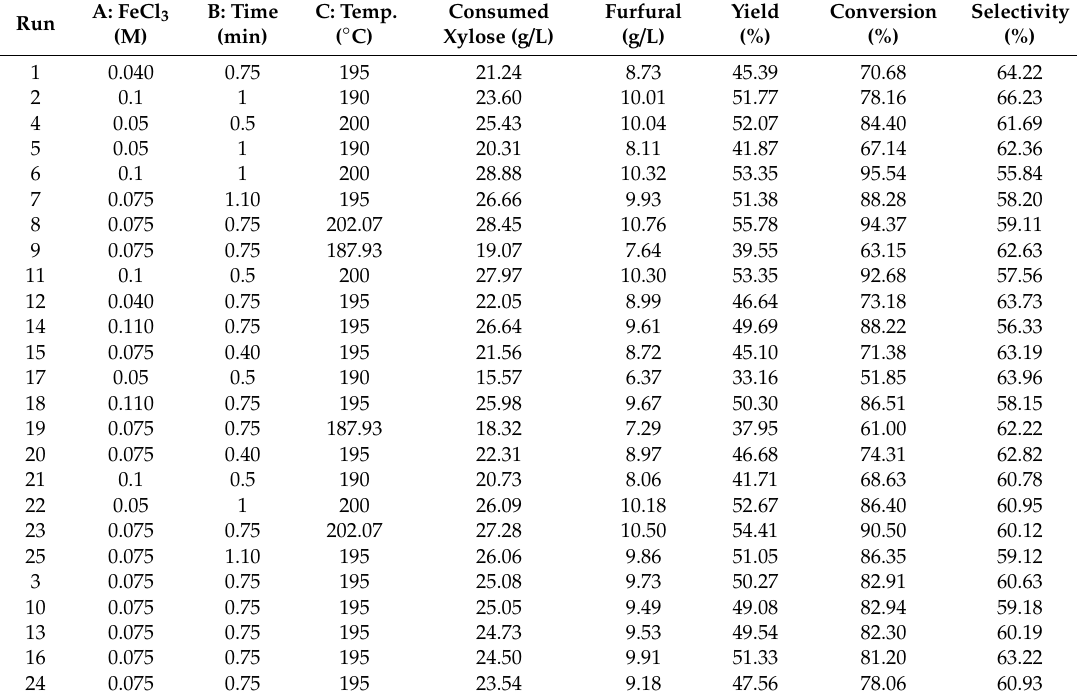
Table 3. Results (consumed xylose, furfural produced, yield, conversion, and selectivity) of the rotatable composite central design (duplicates of the star points + 5 central